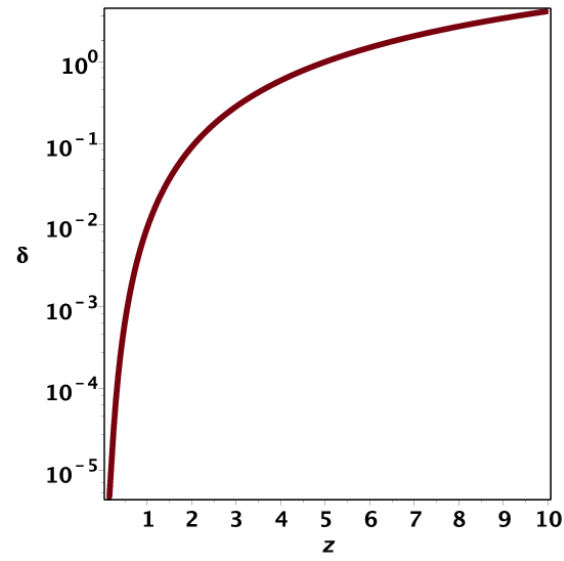
Figure 2. Percentage error, δ , relative to the Padè approximated luminosity distance (see Equation (14)) when H 0 69.6 kms (cid:1) 1 Mpc (cid:1) 1 and Ω M (cid:16)